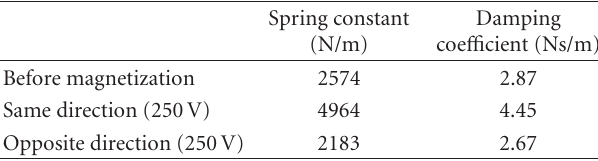
Table 5: Measurment results of impulse